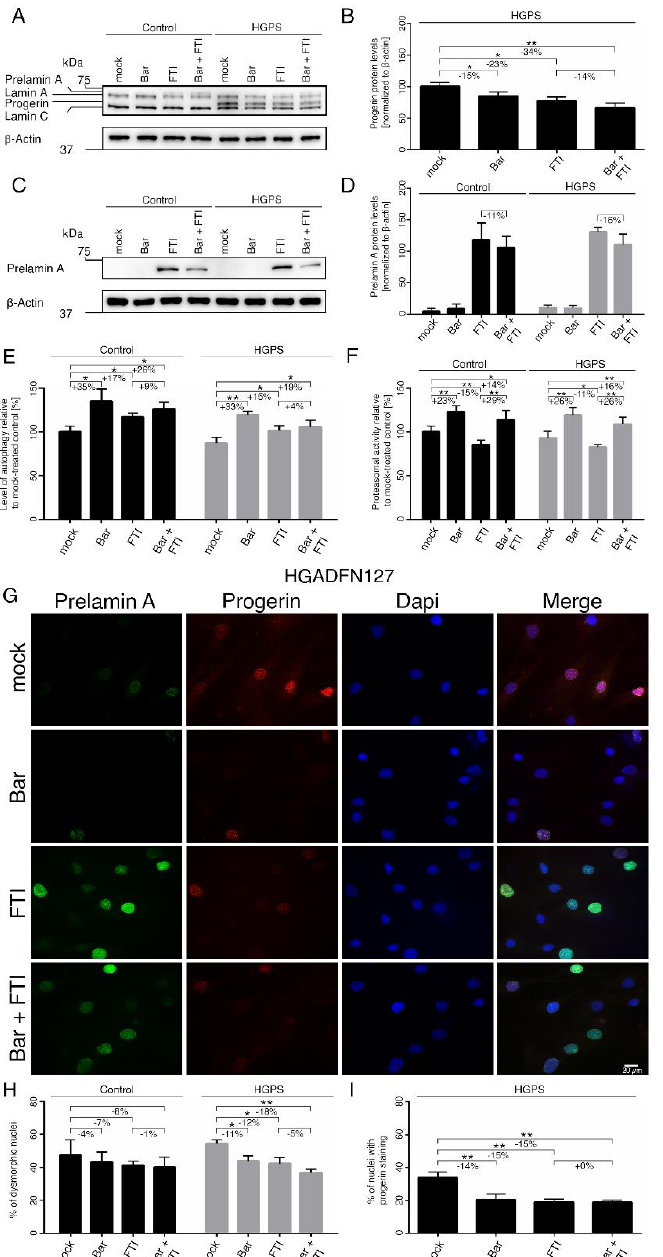
Figure 4. Bar, FTI and combination treatment prevent nuclear blebbing and progerin nuclear accu- mulation. ( A , C ) Representative images of western blots for lamin A/C and prelamin A. Cultures at 15% SNS were either treated with vehicle (DMSO), Bar (1 µM), FTI (0.025 µM), or combined drugs for a period of nine days. Quantification of progerin ( B ) and prelamin A ( D ). ( E ) Autophagy activity was determined by measuring MDC levels using fluorescence photometry. ( F ) Proteasome activity was determined by measuring chymotrypsin-like proteasome activity using Suc-LLVY-AMC as a substrate. ( G ) Representative immunofluorescence images of HGPS (HGADFN127) fibroblasts treated for nine days as indicated. Antibodies against prelamin A (green) and progerin (red) were used, and DNA was stained with DAPI. Fluorescence images were taken at 40 × magnification. Scale bar: 20 µ m. ( H , I ) The same staining as in ( G ) and Figure S1a was used to determine the frequency of misshapen nuclei (dysmorphic) and the number of nuclei with bright progerin signals. An average of at least 900 nuclei were counted. Graphs show mean ± SD. Representative images are shown ( n = 3; * p < 0.05, ** p <